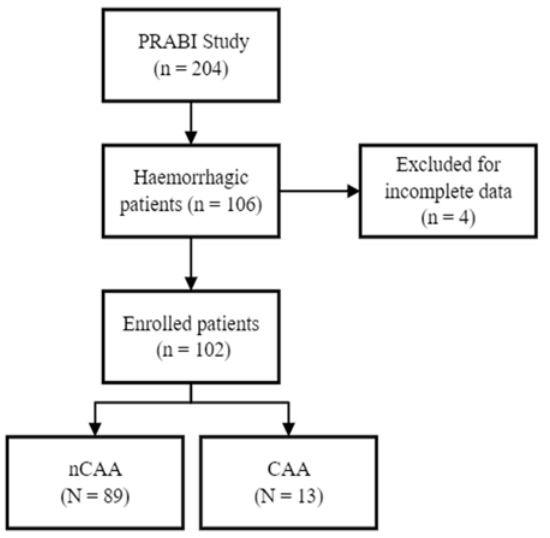
Figure 1. Enrollment flowchart. Legend: PRABI study: clinical, neurophysiological and genetic, predictors of recovery in patients with severe acquired brain injuries; CAA: cerebral amyloid angiopathy; nCAA: non ‐ cerebral amyloid angiopathy.